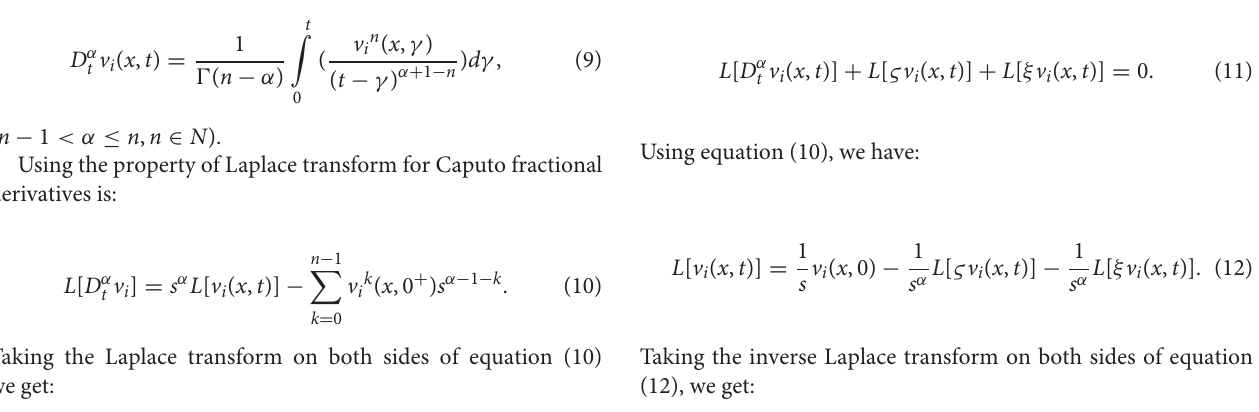
1 for WBK equation. =